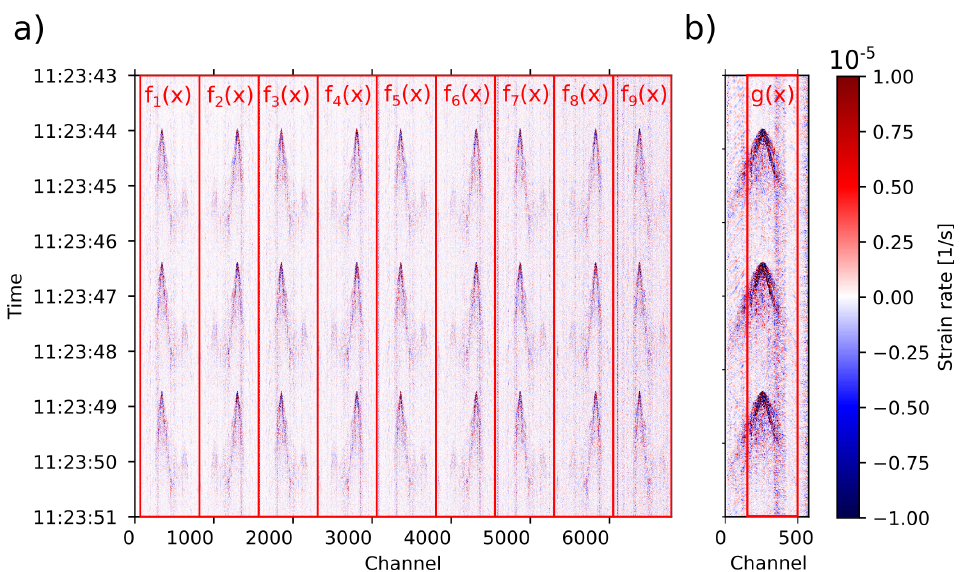
Figure 3. Raw data for ( a ) standard and ( b ) engineered fiber showing signals of tap tests. The data were divided into N = 9 windows that represent the fiber instances of Figure 2, while g ( x ) represents the defined section of the engineered fiber. The signals shown were used only for the purpose of finding the channel correspondence between the fiber instances of the standard fiber and between standard and engineered